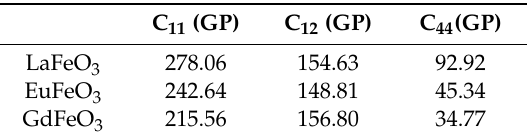
Table 2. Calculated mechanical properties of RFeO 3 (R = La, Eu,